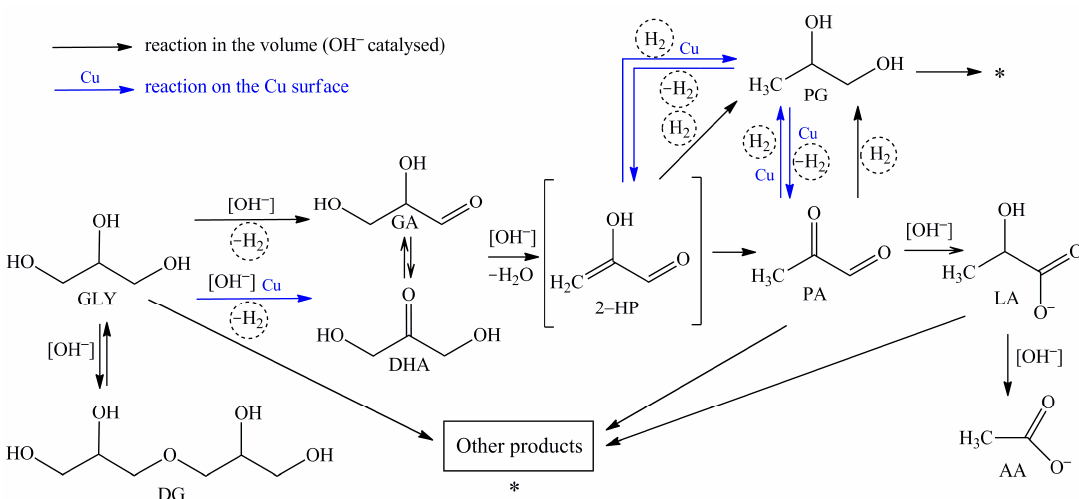
Figure 1. Proposed reaction pathways of the glycerol conversion into LA in the alkaline media (black arrows indicate homogeneous catalytic conversion; blue arrows show reactions occurring on the surface of Cu